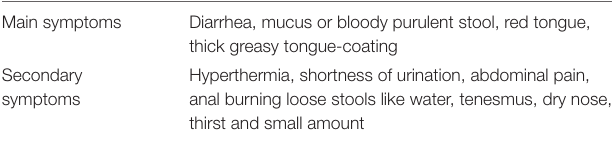
TABLE 1 | Diagnostic criteria for DHD